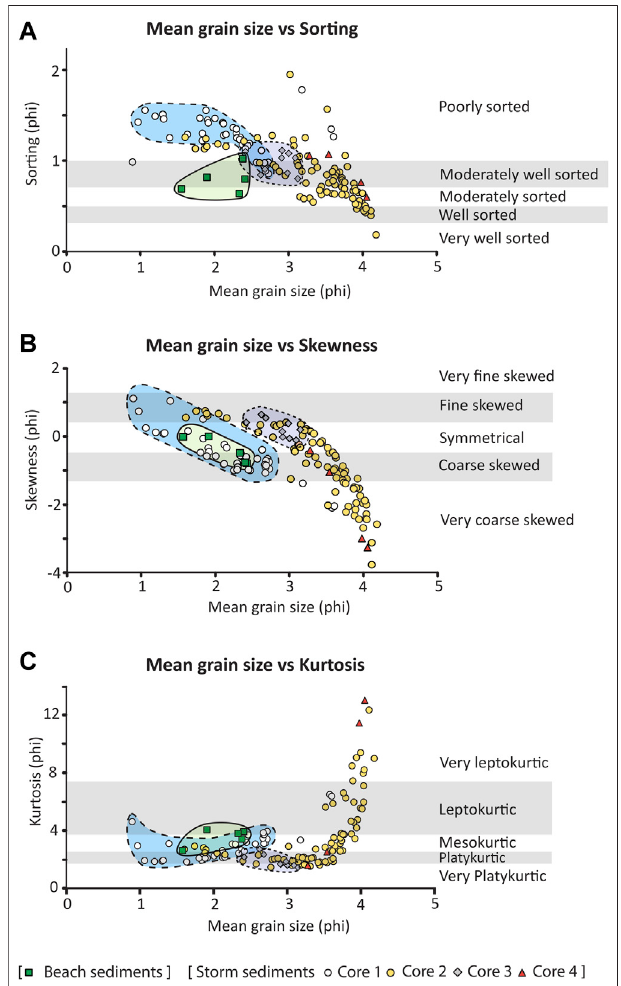
FIGURE 10 | Plot of the mean grain size vs. (A) sorting, (B) skewness, and (C) kurtosis (phi scale) from the beach sediment and candidate storm sediments of cores 1 – 4. Plot of the mean grain size vs. sorting shows the differentiation of storm and beach sands clearer than the other two scatter plots, while the plot of mean grain size vs. skewness and mean grain sizevs.kurtosisshowatrend.Greencolorpolygonindicatedbeachsediment, blue color polygon with dash line indicated candidate storm sediments of cores 1, and gray color polygon with dash line indicated candidate storm sediments of cores 3,